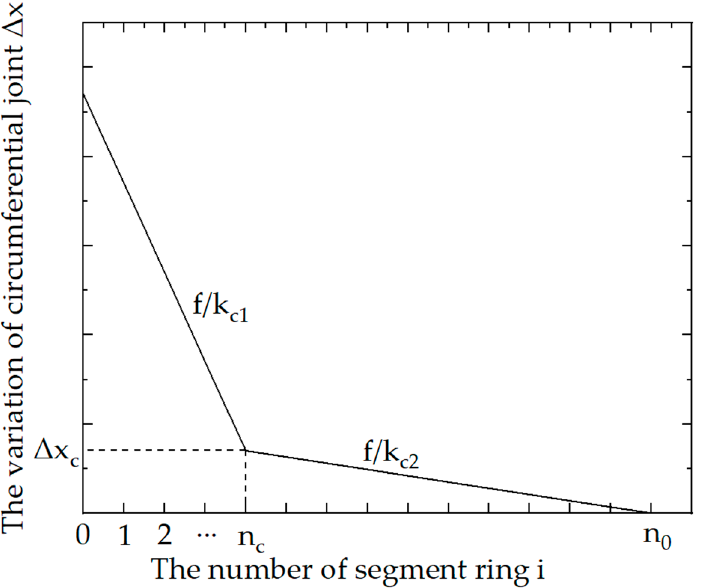
Figure 5. Relationship curve of the circumferential joint variation with different numbers of segment rings.